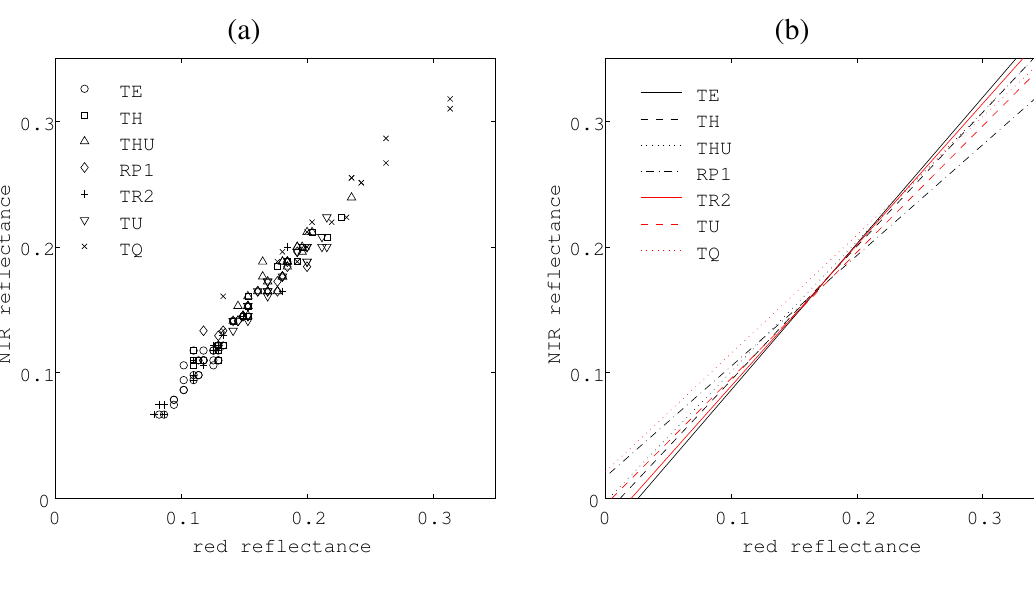
Reflectance spectra of the soil samples (a), and the soil lines for each soil category